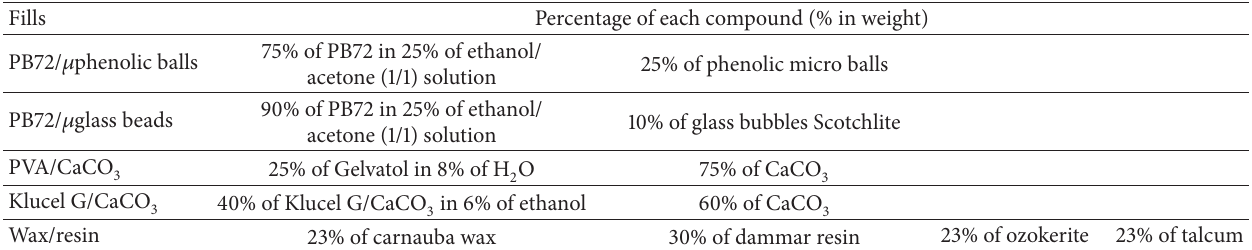
Table 1: Composition of fills.